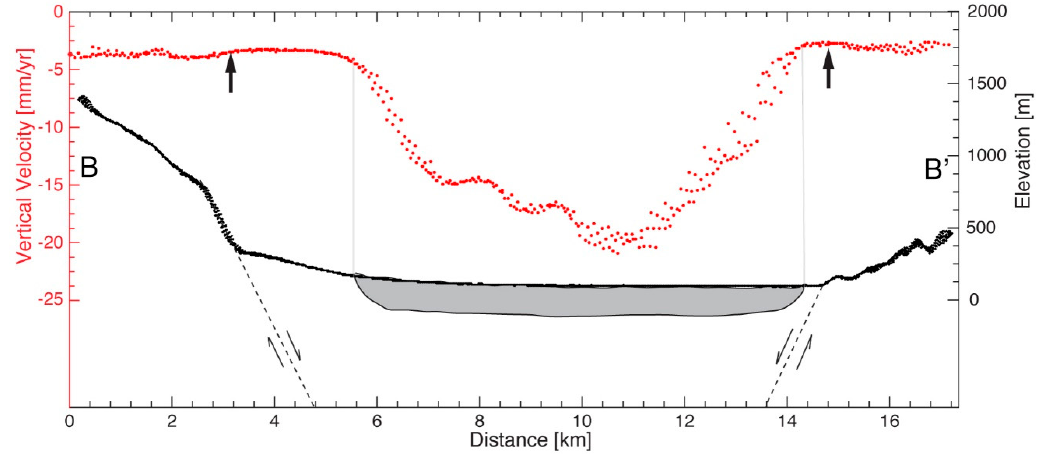
Figure 9. Cross section showing vertical deformation rates in red and altitude in black taken from b– b’ profile shown in Figure